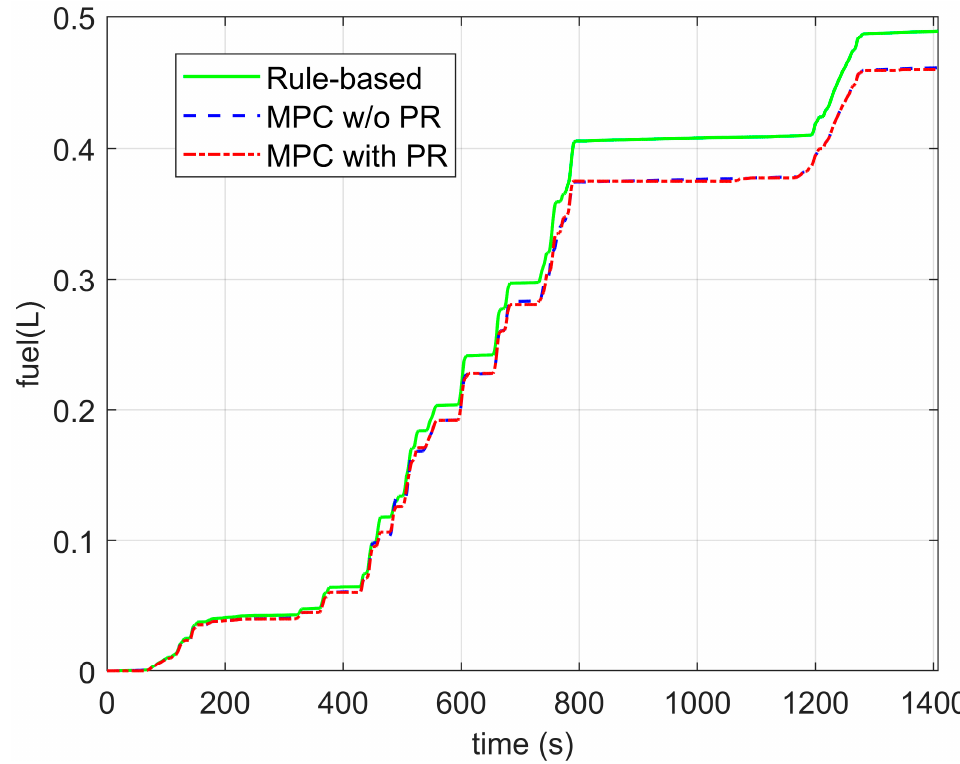
Figure 12. The fuel consumption pro fi le.